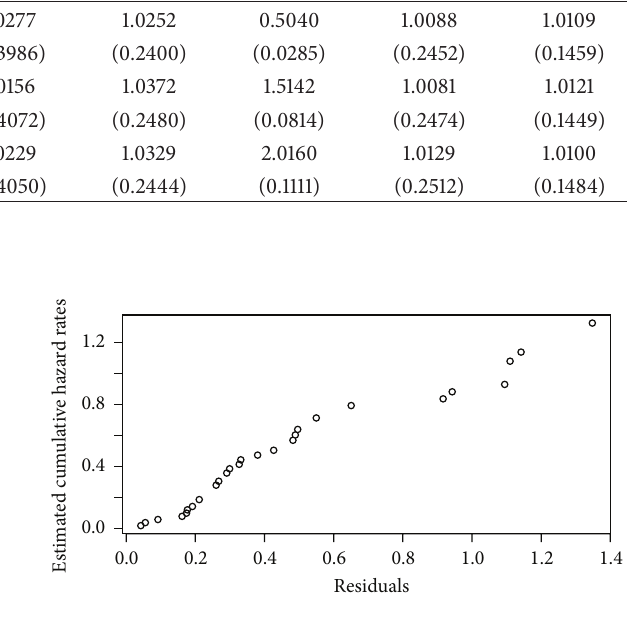
Figure 1: Plot of cumulative hazard rates of Cox-Snell residuals versus